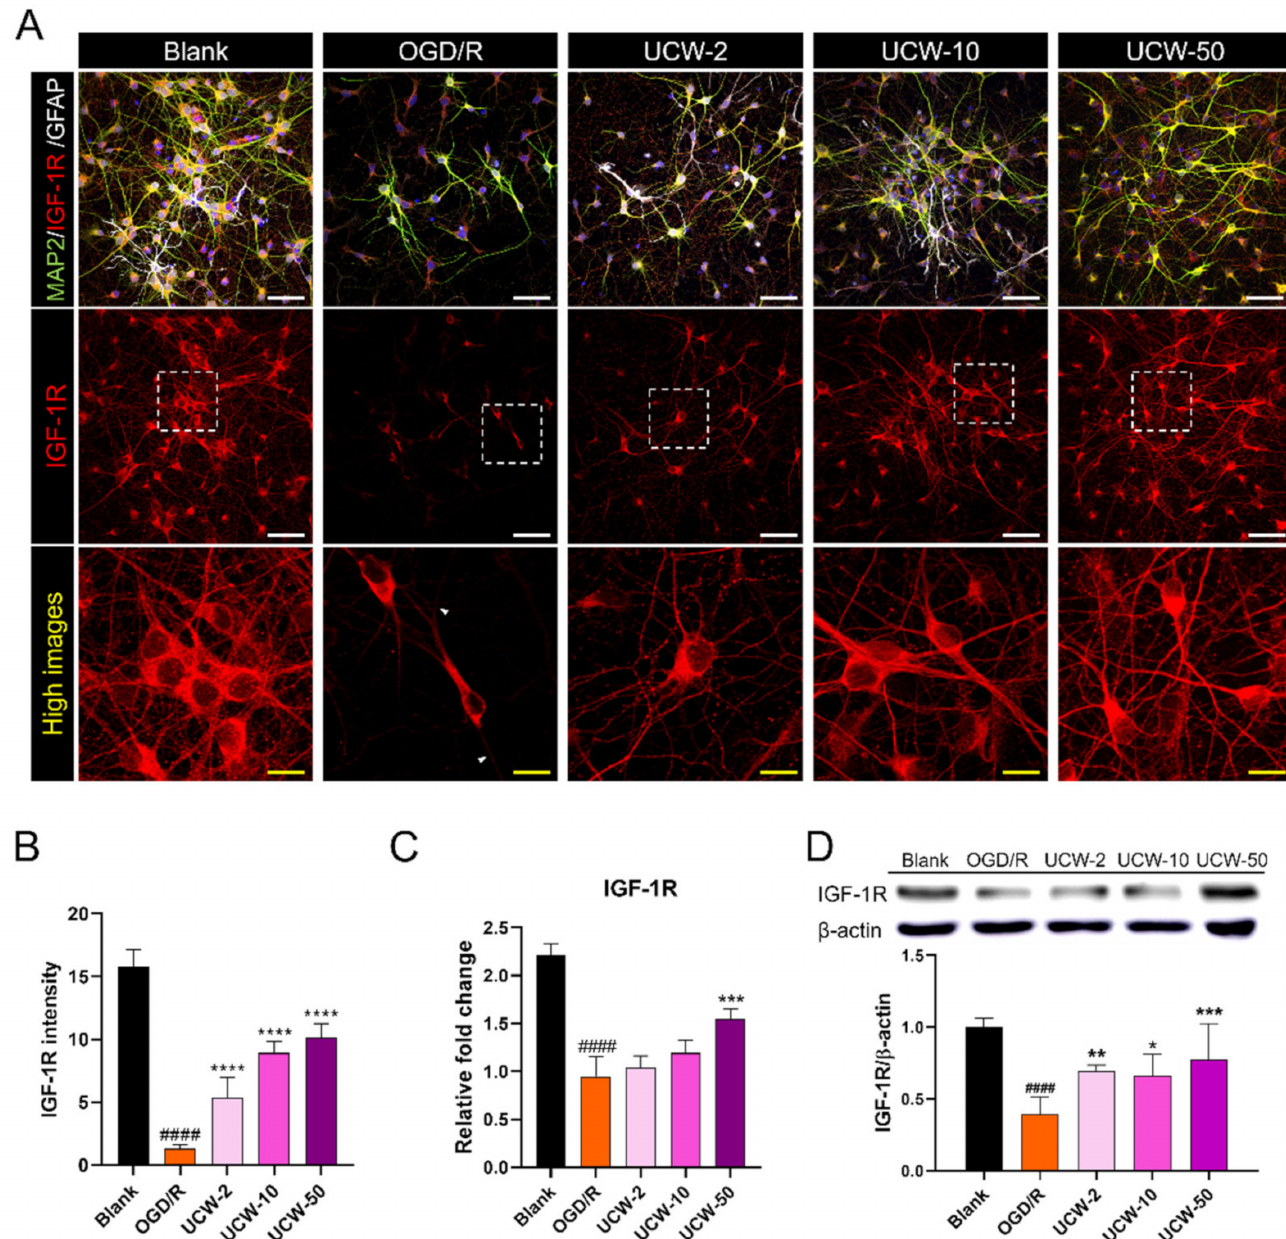
Figure 5. Neuroprotective effect of UCW on OGD/R-induced hypoxia damage by activating the IGF-1R signaling in primary cortical neurons. ( A ) Representative images of immunocytochemistry for IGF-1R (red), MAP2 (green), and GFAP (white) in blank, OGD/R injury, UCW + OGD/R injury. White scale bar = 100 µ m, yellow scale bar = 10 µ m. ( B ) Quantitative analysis of IGF-1R intensity estimated based on measurements obtained from 10 non-overlapping fields in each group ( n = 10). ( C ) The relative mRNA expression level for IGF-1R using real-time PCR in each group ( n = 4). ( D ) Relative quantification for the IGF-1R protein expression using Western blotting in each group ( n = 4). Data are expressed as the mean ± SEM. Significant differences were analyzed via ordinary ANOVA with Tukey’s post-hoc analysis as follows: #### p < 0.0001 vs. blank group; * p < 0.05, ** p < 0.01, *** p < 0.001, and **** p < 0.0001 vs. the OGD/R